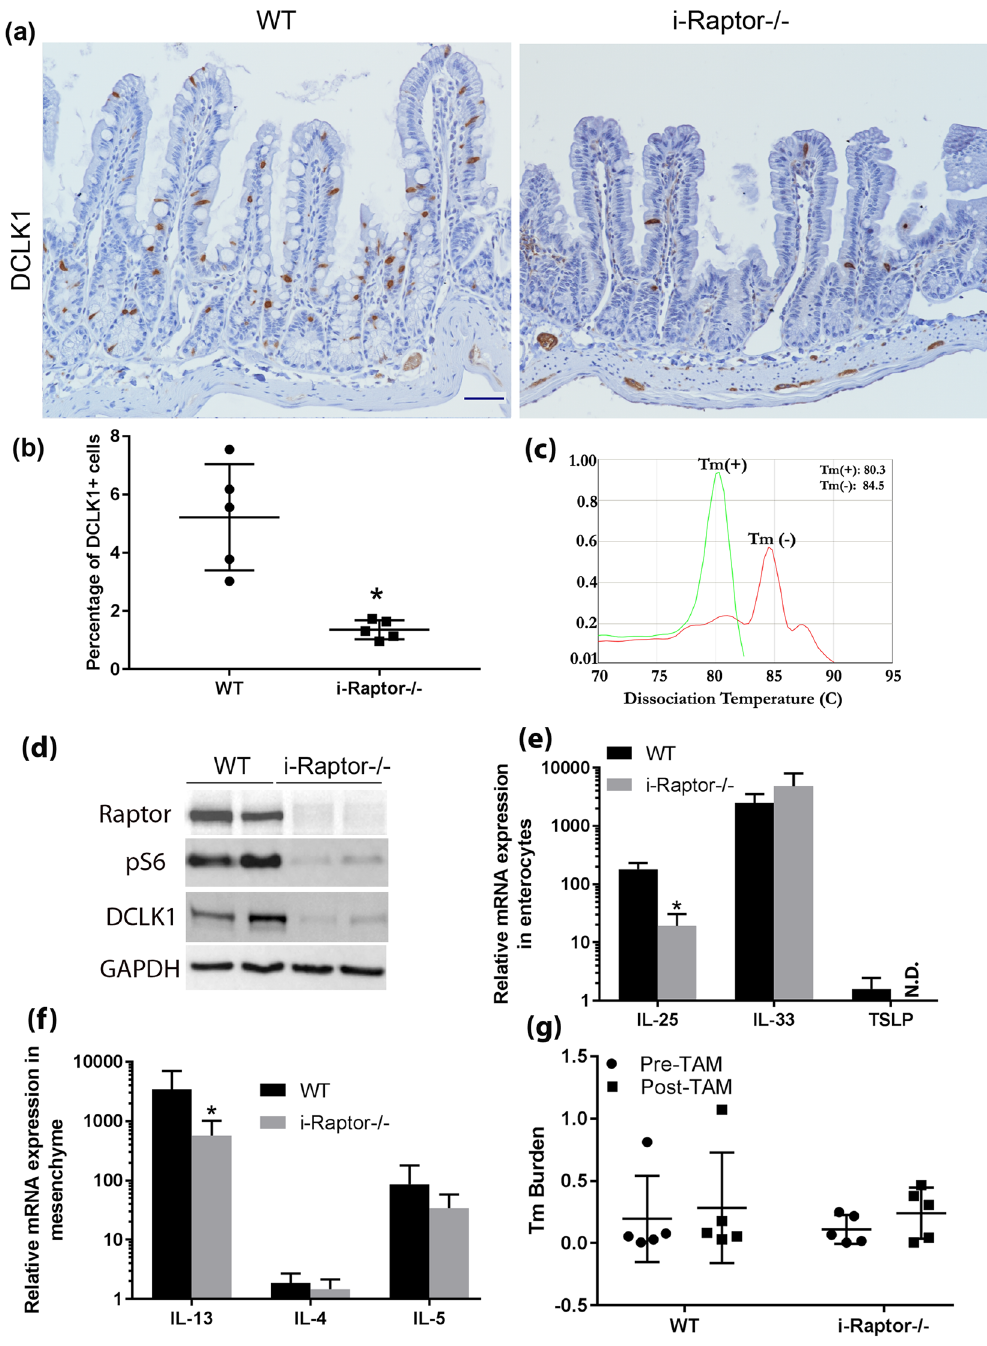
Figure 1. Enterocyte-specific Raptor is required for maintaining tuft cell abundance and function. Vilin- Cre ER ( − ); Raptor ( f / f ) (WT, n = 6) and Vilin-Cre ER ( + ); Raptor ( f / f ) ( i - Raptor − / − , n = 6) mice were injected intraperitoneally with Tamoxifen (TAM) for 3 consecutive days and small intestine removed 2 weeks later. ( a ) Representative immunohistochemistry (IHC) shows tuft cells in brown using anti-DCLK1 antibody. ( b ) Quantification of tuft cells based on at least 20 well orientated crypt-villi axis. ( c ) Representative dissociation curve shows RT-PCR amplification of 28S rRNA gene from Tritrichomonas muris (Tm) positive or negative feces. ( d ) Representative Western blot analysis of the protein expression as indicated. GAPDH was used as a loading control. ( e ) Real-time PCR measurements of cytokines expression in enterocytes as indicated. ( f ) Real- time PCR measurements of cytokines expression in lamina propria as indicated. ( g ) Tm burden quantified from stools collected before and 7 days after TAM injection. Mean ± SD is shown. Student’s t test ( * p <